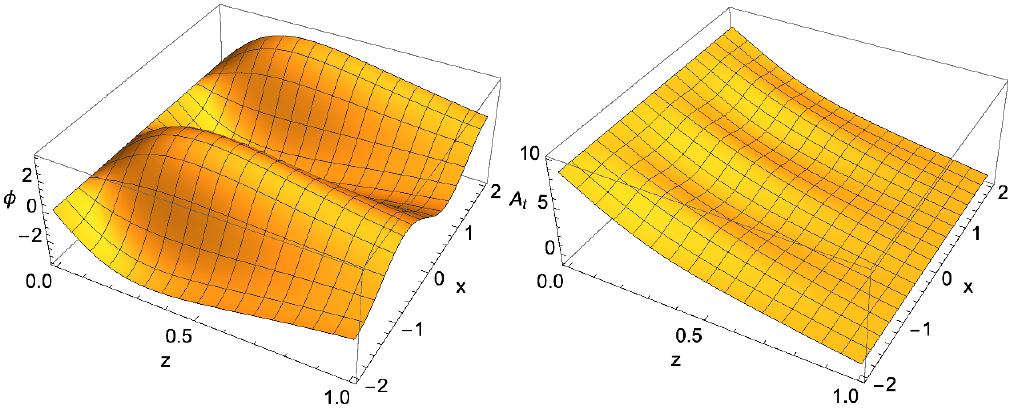
Figure 4 . Inhomogeneous con(cid:12)gurations of the bulk solutions of (cid:30) ( z; x ) (left) and A t ( z; x ) (right) with three nodes on the x -axis for (cid:22) = 8 :